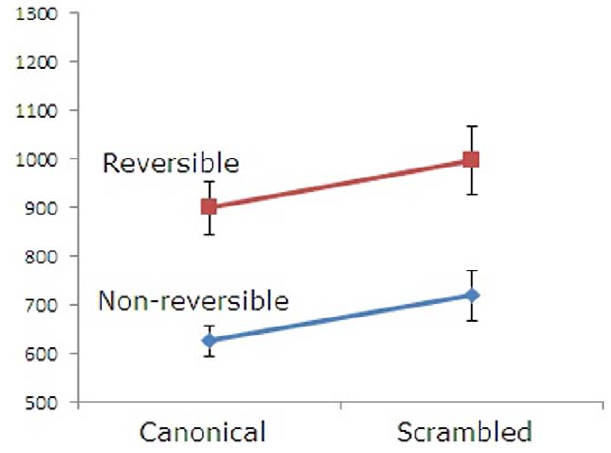
Figure 2. Reading times at the verb position. Mean reading times for the predicate among four conditions: reversible canonical, non- reversible canonical, reversible scrambled, and non-reversible scram- bled sentences. Error bar denotes standard mean